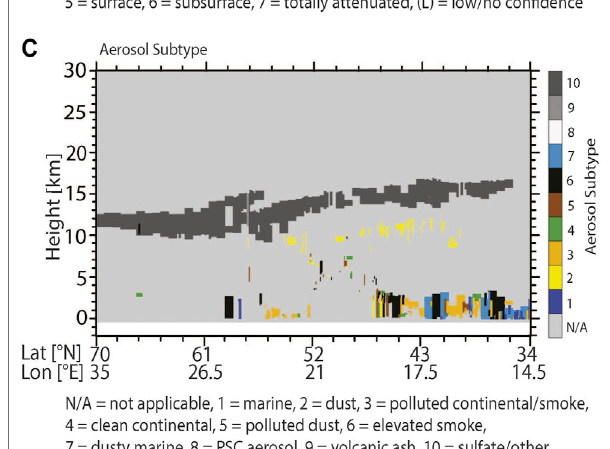
Frontiers in Environmental Science |